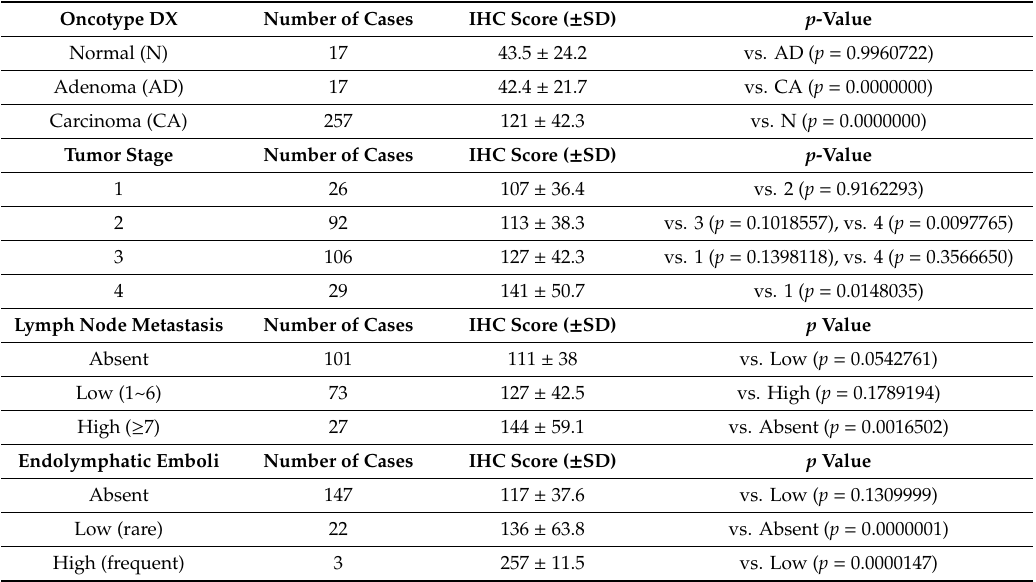
Table 1. Demographic and clinicopathological characteristics of studied colorectal cancer (CRC) patients *.